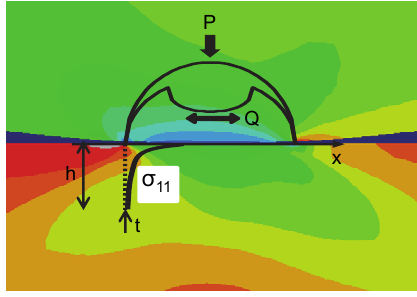
Figure 6: Stress extraction along crack path for a fretting fatigue